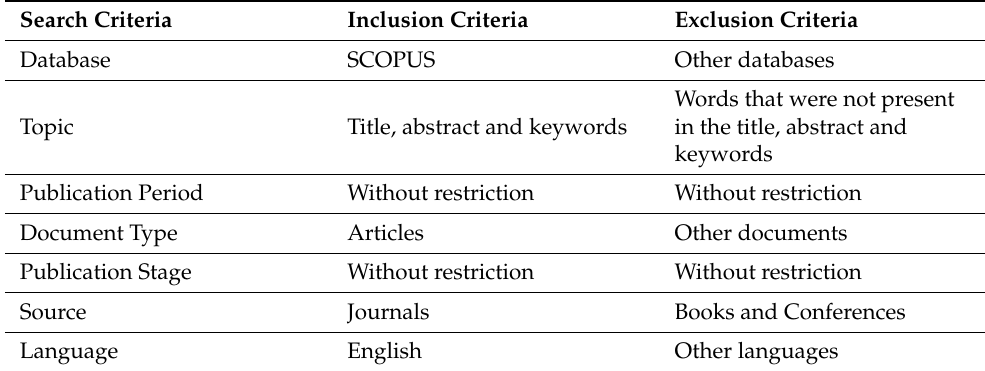
Figure 2. Literature review process flow diagram. Source: Adapted from [38]. Table 1. Inclusion and Exclusion Criteria.